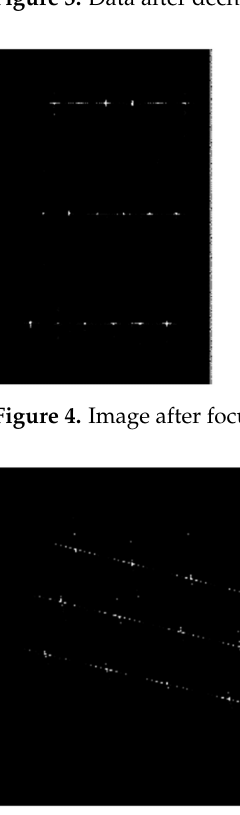
Figure 3. Data after dechirp and range cropping.